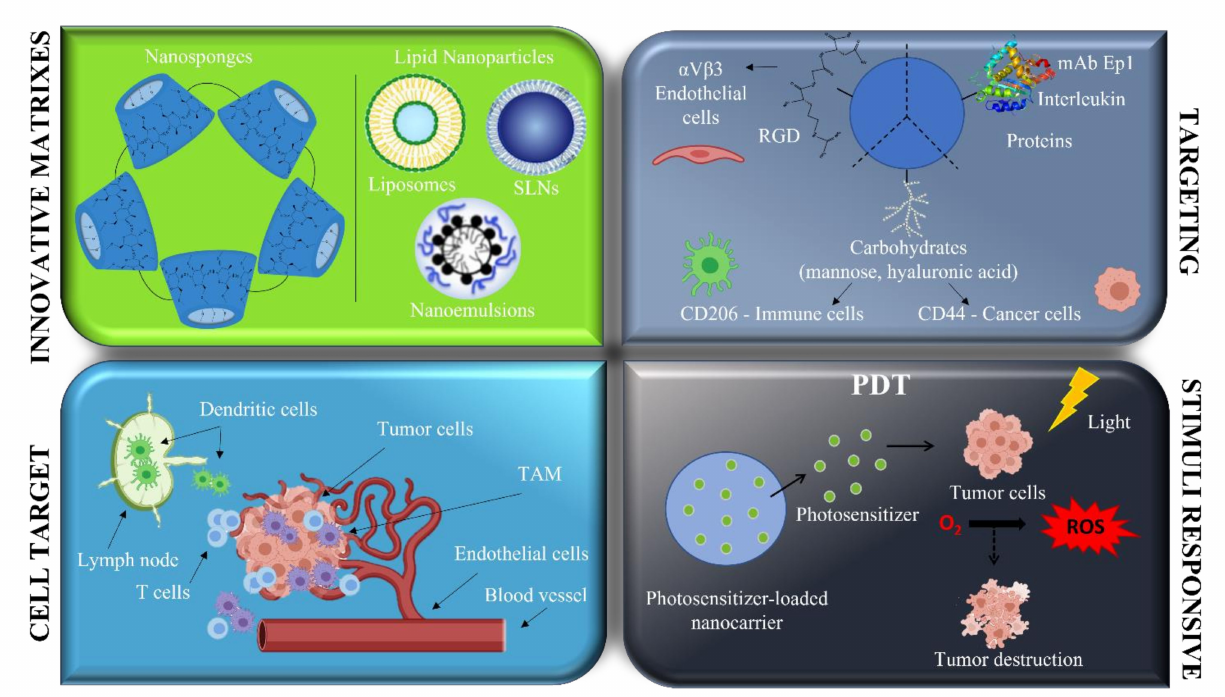
Figure 3. Main drug delivery strategies involving nanosystems for melanoma treatment within the Italian concern (Created with